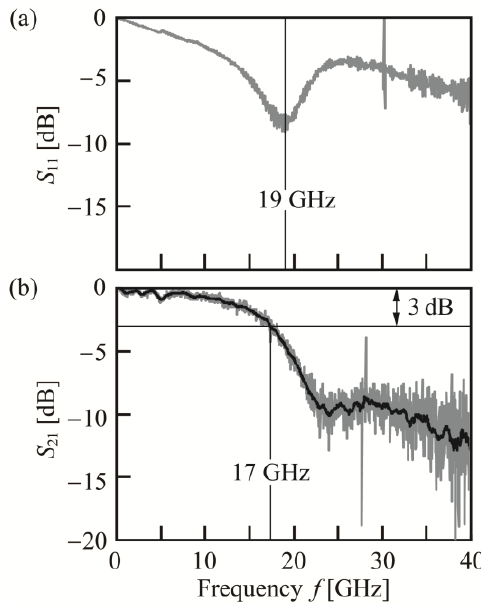
Figure 3. Measured S parameters: ( a ) S 11 ; ( b ) EO S 21 at λ = 1554 nm. Gray line shows raw data. Black line shows averaged values within each ~0.5 GHz range.